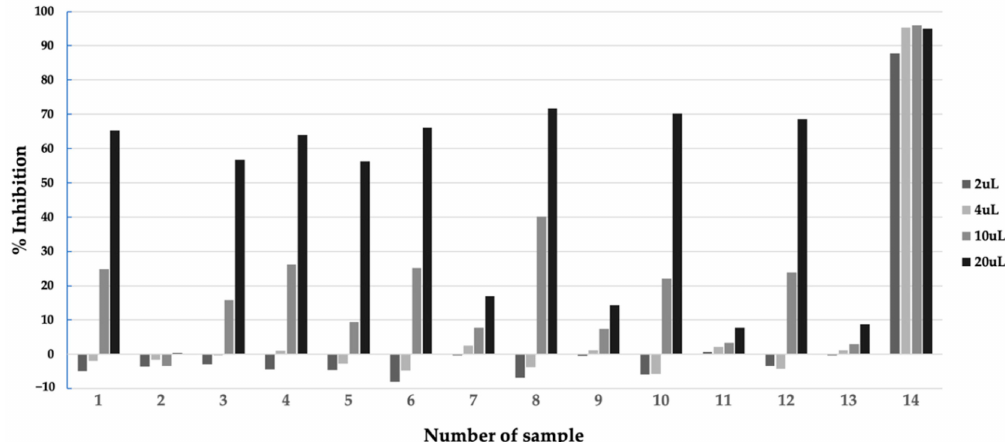
Figure 4. Inhibitory activity of samples from preliminary extraction test of extract of Aspergillus sp.